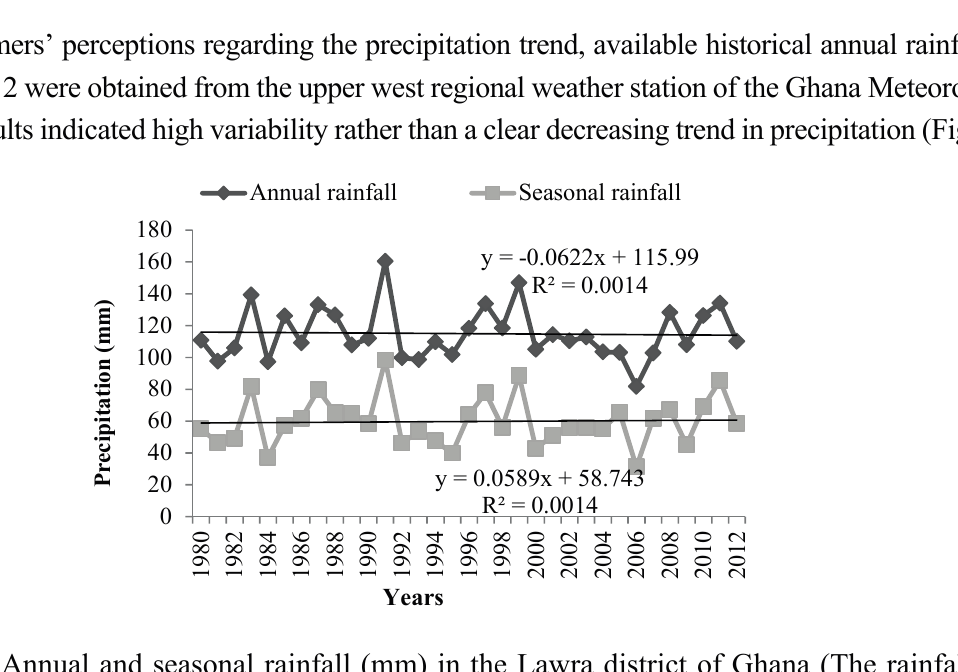
Figure 1. Farmers’ perceptions of long-term changes in temperature and precipitation in the Lawra district of Ghana.